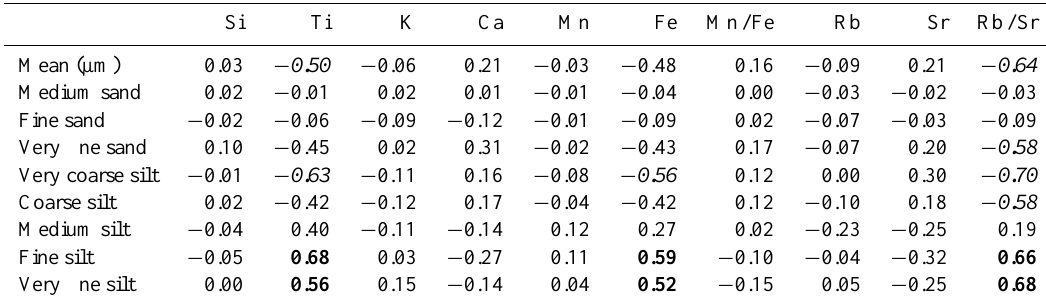
Table 1. Pearson ( r ) correlation coefficients for selected elements and element ratios measured by XRF core scanning vs. the mean grain size and percentages of selected grain-size classes of samples from Lake El’gygytgyn ( n = 858). Correlation coefficients above 0.5 (bold) and below − 0.5 (italic) are